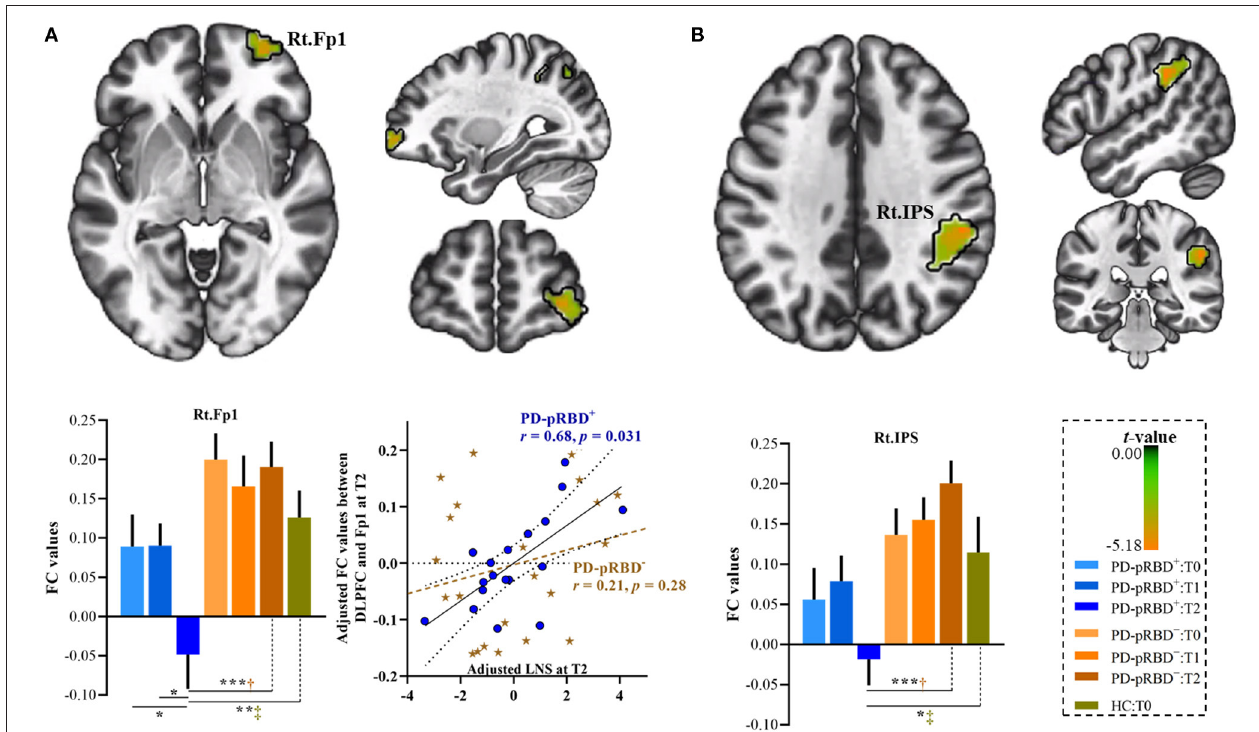
FIGURE 5 | Progressive FC decrease in the left DLPFC in PD-pRBD + compared with PD-pRBD − at 3-year follow-up evaluation. (A) Decreased FC in the right Fp1; (B) Decreased FC in the right IPS. Bar graph showed the mean extracted FC values in these regions. Scatter plots presented the relationship between FC values and scores of LNS test. The results were thresholded based on an uncorrected voxelwise height threshold of p < 0.001 combined with an FWE-corrected clusterwise threshold of p < 0.05. Mixed repeated measures analysis of variance was performed to compare the longitudinal changes between PD groups with visit-time (i.e., T0, T1, T2) as within-group factor and group (i.e., PD-pRBD + and PD-pRBD − ) as between-group factor. Post-hoc comparisons were further performed to determine longitudinal changes over time within group and differences between groups at each visit time. Raw data for LNS and FC were adjusted for confounding variables of age, sex, education, disease duration, and levodopa dose, as demonstrated in x-axis and y-axis. Fp1, lateral frontopolar area 1; LNS, letter-number sequencing; IPS: intraparietal sulcus; T0, fMRI data at onset; T1, the 1-year follow-up evaluation; T2, the 3-year follow-up evaluation. PD-pRBD + , Parkinson’s disease (PD) with probable rapid eye movement (REM) sleep behavior disorder (pRBD); PD-pRBD − , PD without pRBD; Lt, left; Rt, right. † showed significant differences between patients with PD-pRBD + and PD-pRBD − ; ‡ s howed significant differences between PD-pRBD + patients and HCs. * p < 0.05 with Bonferroni correction; ** p < 0.005 with Bonferroni correction; *** p < 0.001 with Bonferroni